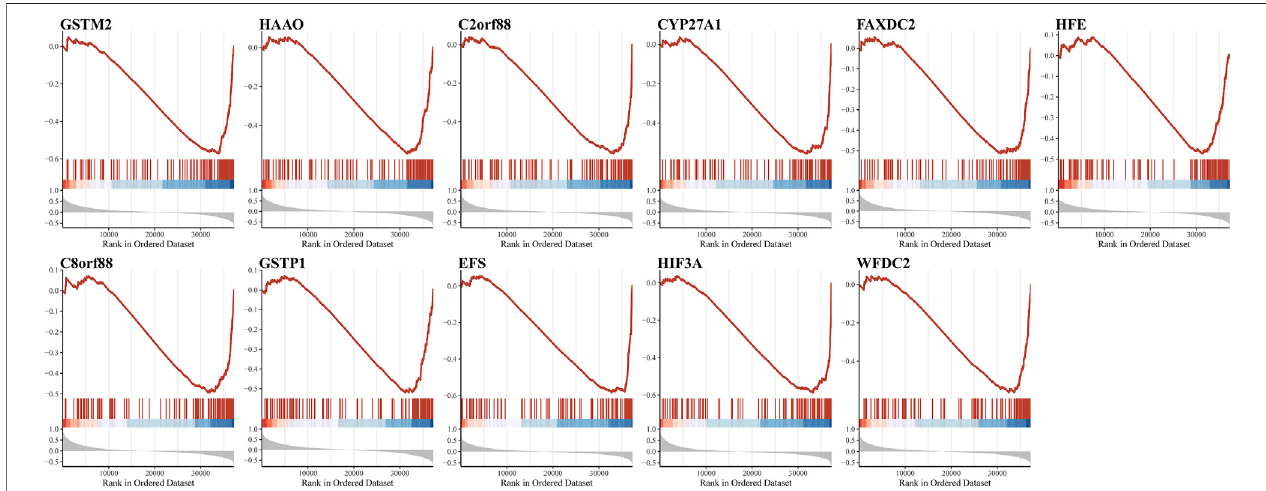
FIGURE 6 | Demonstration of association of aneuploidy driver genes with cell cycle pathways. Because of crucial contributions of cell cycle pathways on aneuploidy, GSEA was utilized to con fi rm association of aneuploidy driver genes with cell cycle pathways.